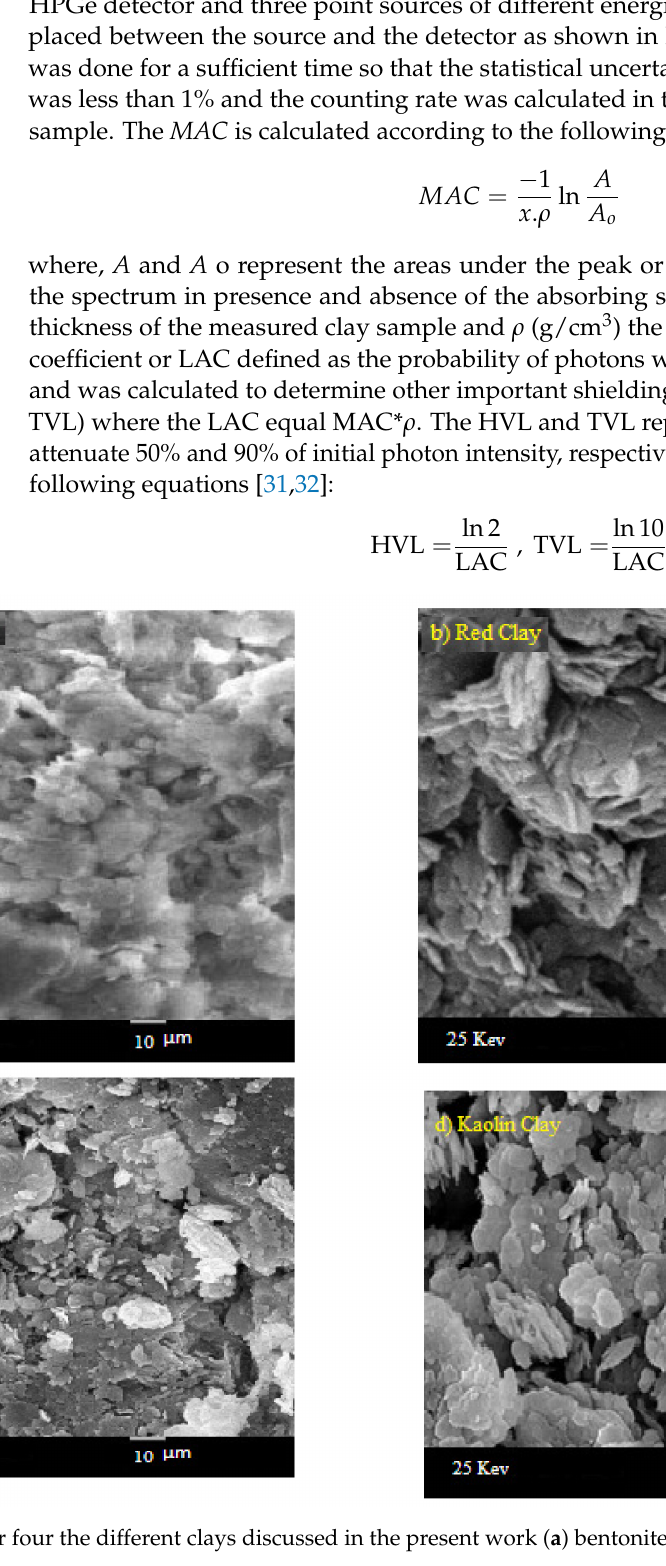
Figure 2. SEM images for four the different clays discussed in the present work ( a ) bentonite clay, ( b ) red clay, ( c ) ball clay ( d ) kaolin